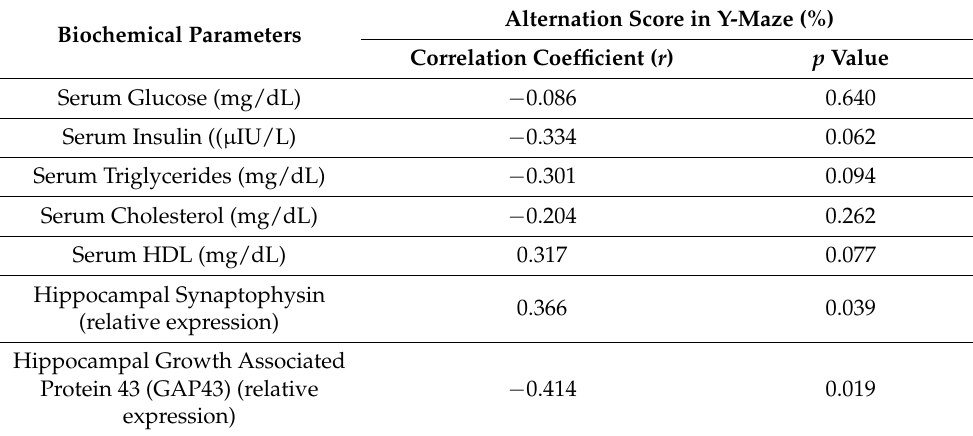
Table 4. Correlation between alternation score in Y-maze (%) and biochemical markers. Biochemical Parameters